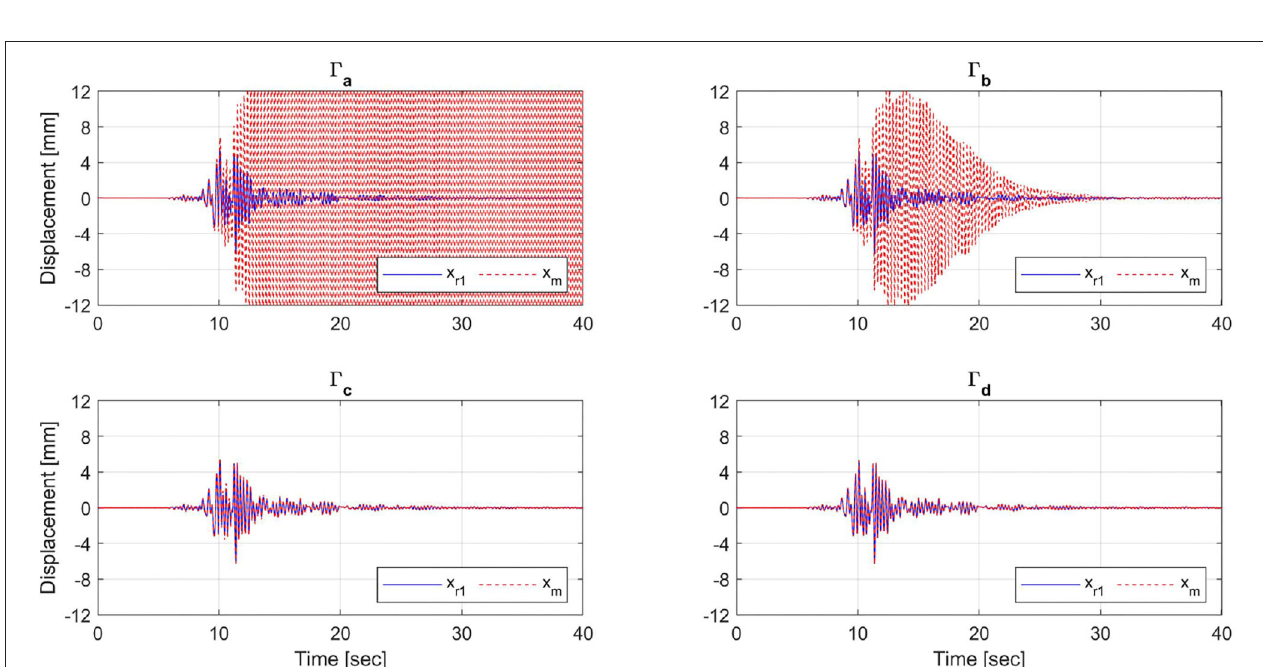
FIGURE 10 | Reference and measured displacements for different adaptive gains.